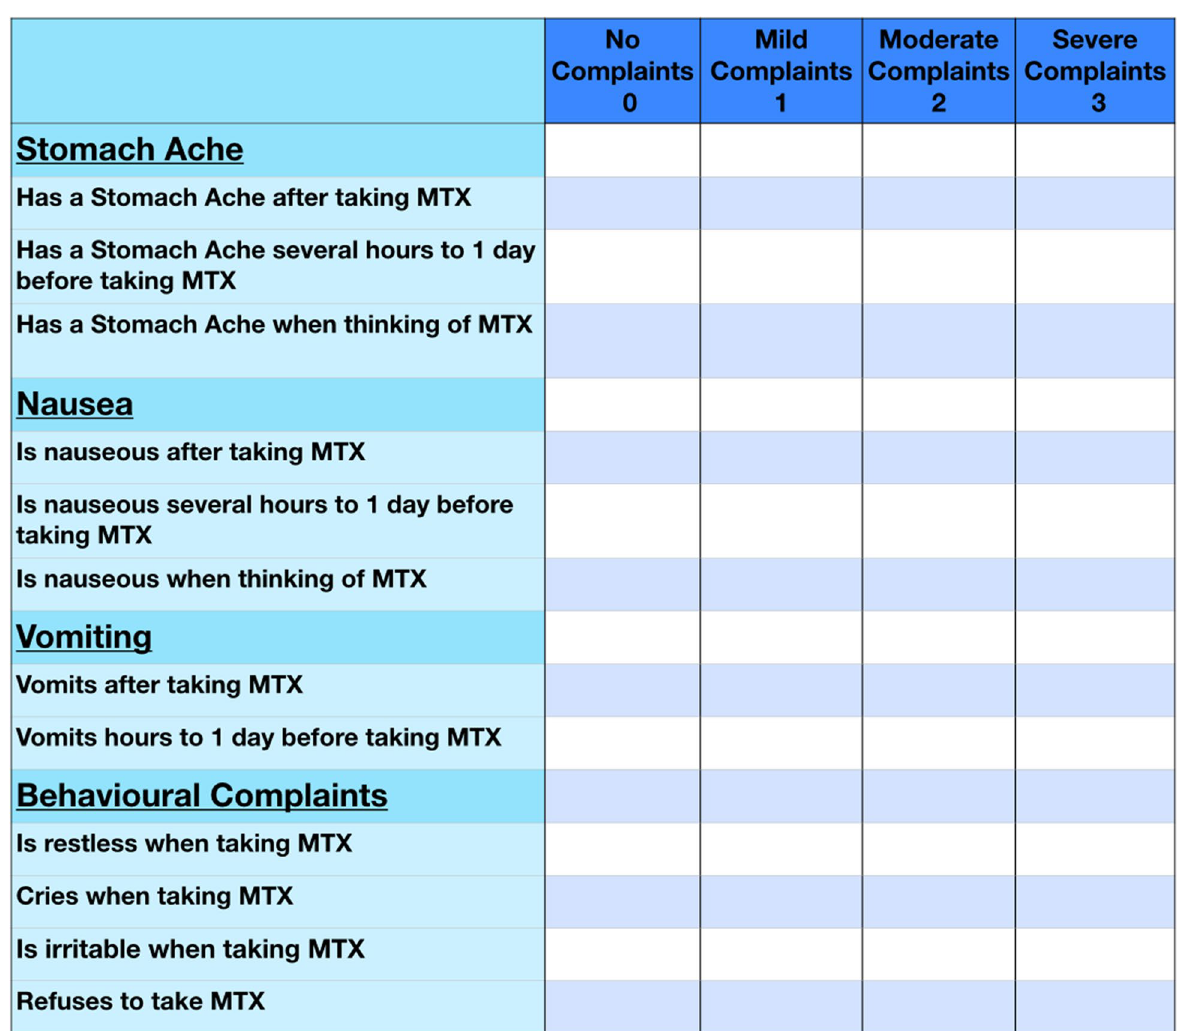
Fig. 2 Methotrexate Intolerance Severity Score (MISS)